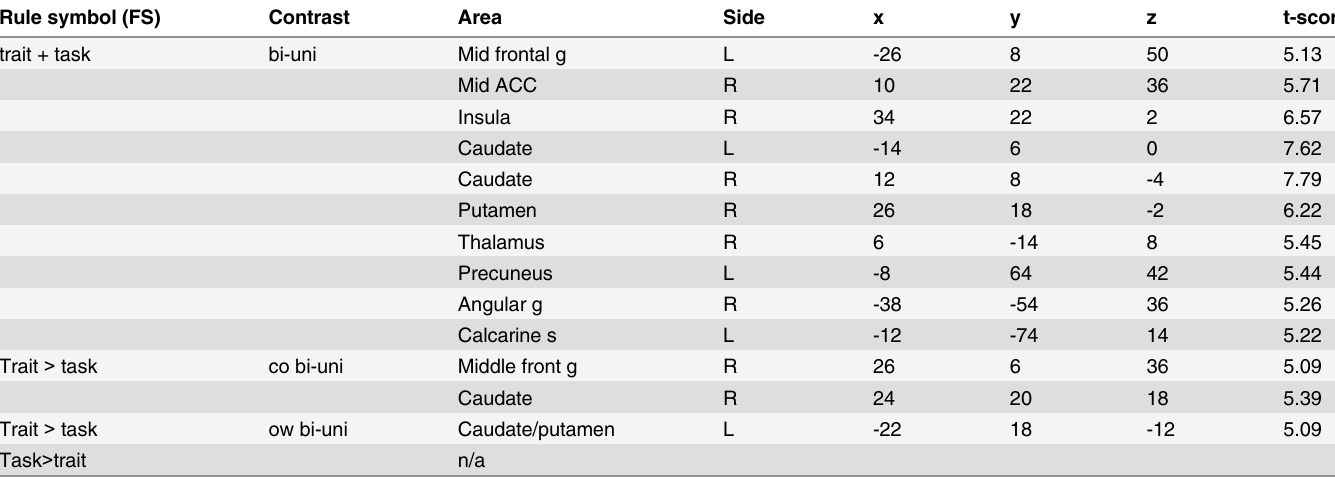
Table 2. Brain activations at a statistical threshold of p < 0.05 FWE-whole brain corrected. Rule symbol (FS) Contrast trait + task